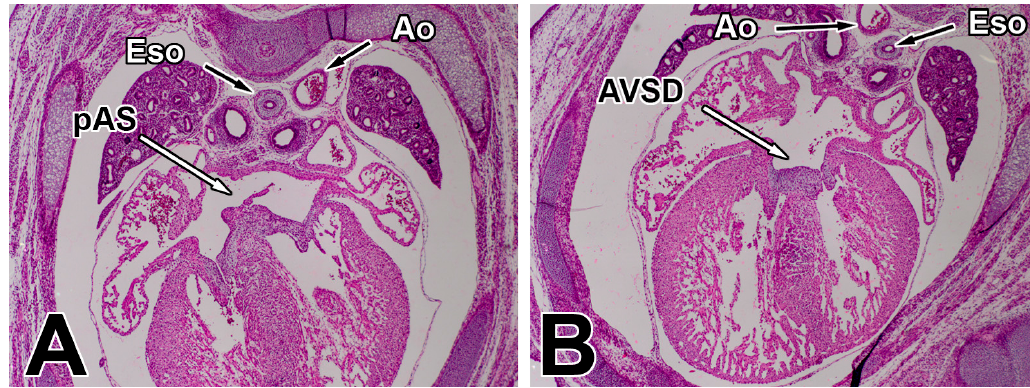
Figure 6. Atrioventricular septal defect in Mef2C-AHF-Cre;Smo fl/fl mouse at ED15.5. This figure shows a control ( A ) and SHF-specific Smo knockout ( B ) mouse embryo at ED15.5. The image in ( A ) demonstrates normal anatomy of the atrioventricular septal complex, whereas the conditional knockout embryo in ( B ) is characterized by an incomplete AVSD. Note also that the dorsal aorta in ( A ) is located in its normal position to the left of the esophagus and the embryonic midline while in ( B ) the dorsal aorta is located to the right of the esophagus. Ao = dorsal aorta, AVSD = atrioventricular septal defect, Eso = esophagus, pAS = primary atrial septum.